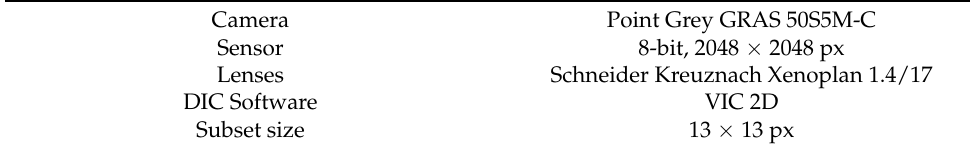
Table 2. DIC parameters.